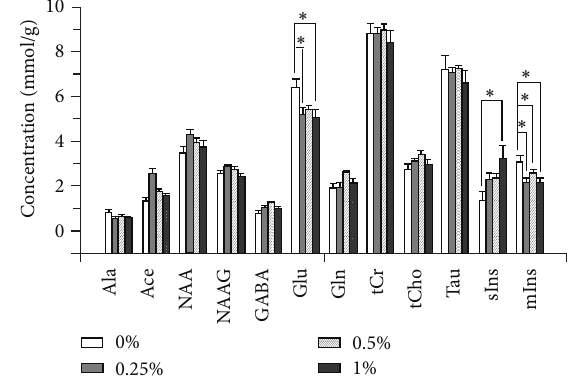
Figure 2: Absolute metabolite concentration in the whole brain of four zebrafish groups (0.00%, 0.25%, 0.50%, and 1.00%): Glu, mIns, and sIns were significantly different. Error bars = SEM. Significance level (ANOVA): ∗ 𝑃 < 0.05 .